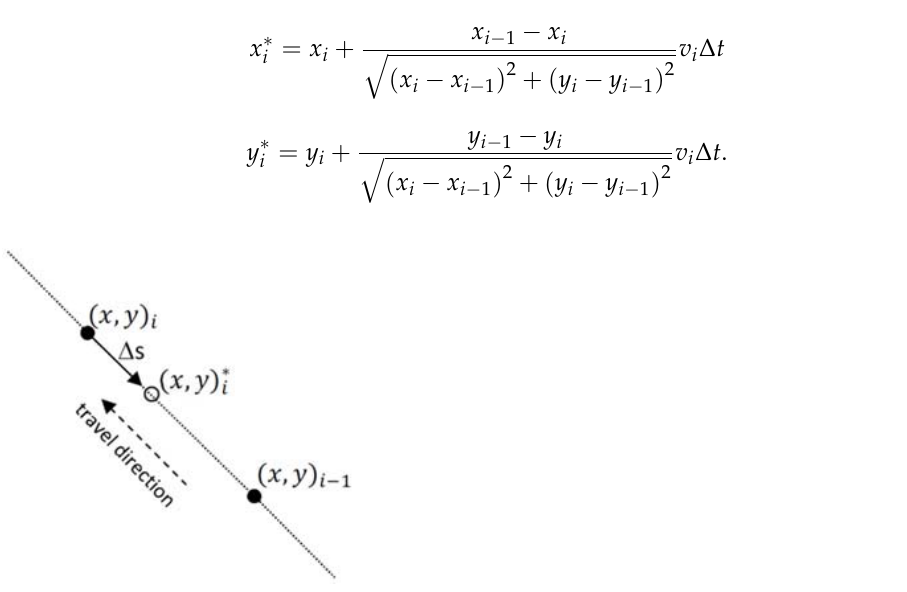
, and ( x , y ) , while i − 1 i , of the latter i